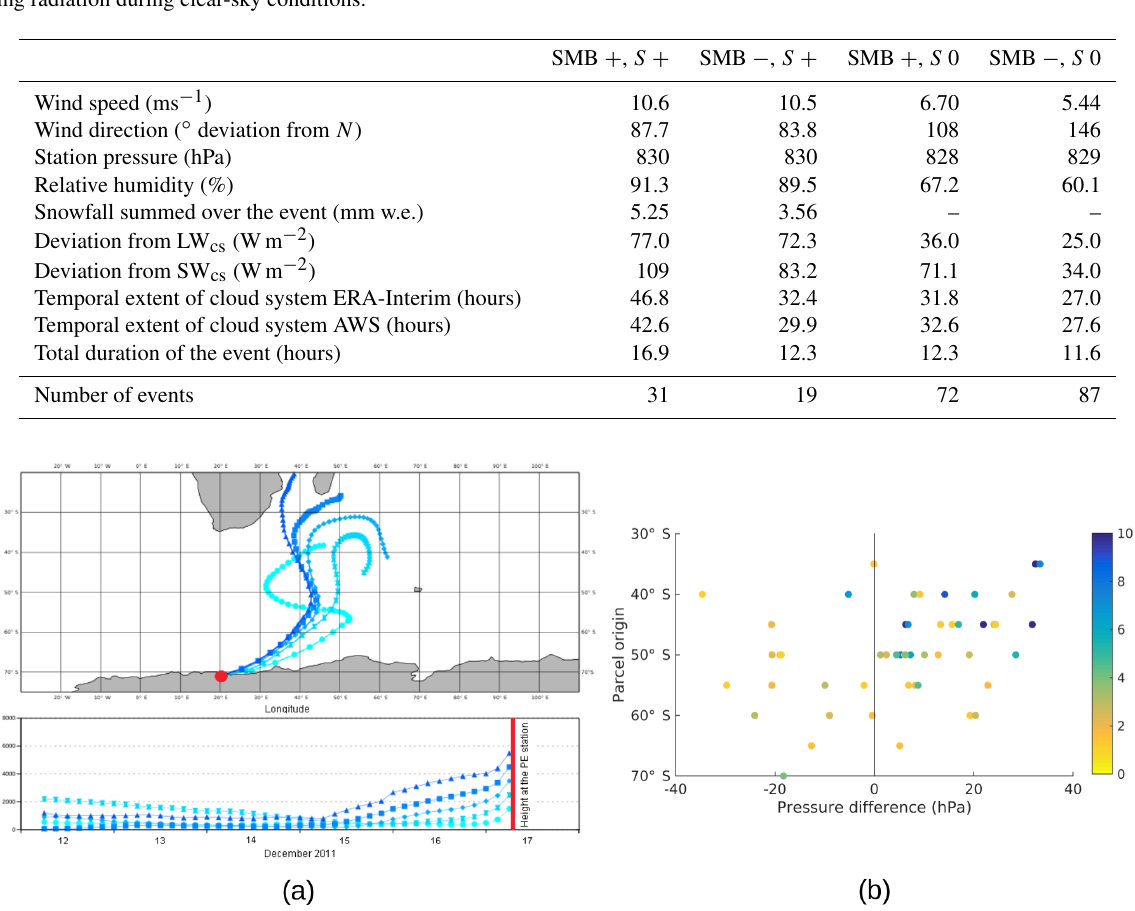
Table 1. Average meteorological statistics for the four types of events stated in Sect. 2.2. Only events during coinciding measurements of the AWS and MRR are included. LW cs denotes the long-wave incoming radiation during clear-sky conditions, while SW cs is the short-wave incoming radiation during clear-sky conditions.